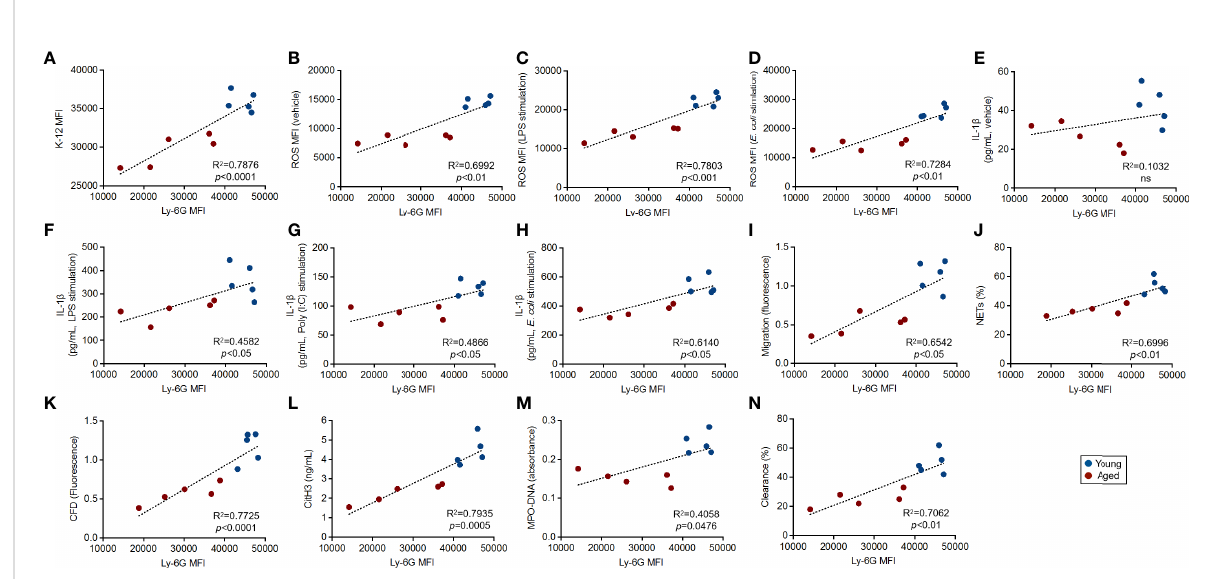
FIGURE 4 Correlation between Ly-6G expression and the parameters of antibacterial activities in the neutrophils Correlations between Ly-6G MFI and parameter values gained by functional assays. The linear regression graphs show correlations of Ly-6G MFIs vs . the values of incorporated K-12 MFIs (A) , basal ROS MFIs (B) , ROS MFIs in LPS (C) , live E. coli stimulation (D) , IL-1 b concentrations in vehicle treated (E) , LPS (F) , poly(I:C) (G) , live E. coli stimulation (H) , migration (I) , parentage of NETosis (J) , CFD concentrations (K) , CitH3 concentration (L) , MPO-DNA amount (absorbance) (M), and percentages of bacterial clearance (N) , respectively. R 2 and p -values were calculated by using GraphPad